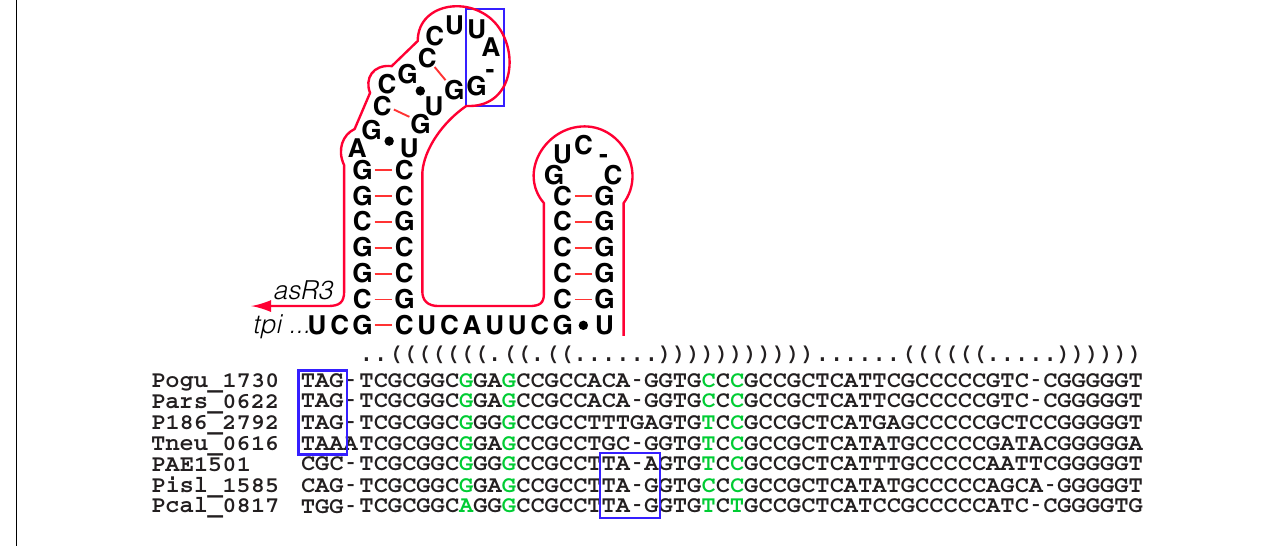
FIGURE 6 |The Pyrobaculum tpi-element and the associated antisense element, asR3 . In all sequenced Pyrobaculum species, a highly conserved primary sequence forms a predicted secondary structure element (upper panel) at the 3 (cid:48) end of the triose-phosphate isomerase gene ( tpi ).The depicted secondary structure contains the stop codon (blue box) in P. aerophilum (PAE1501), P. islandicum (Pisl_1585), and P. calidifontis (Pcal_0817). In P. oguniense (Pogu_1730), P. arsenaticum (Pars_0622),